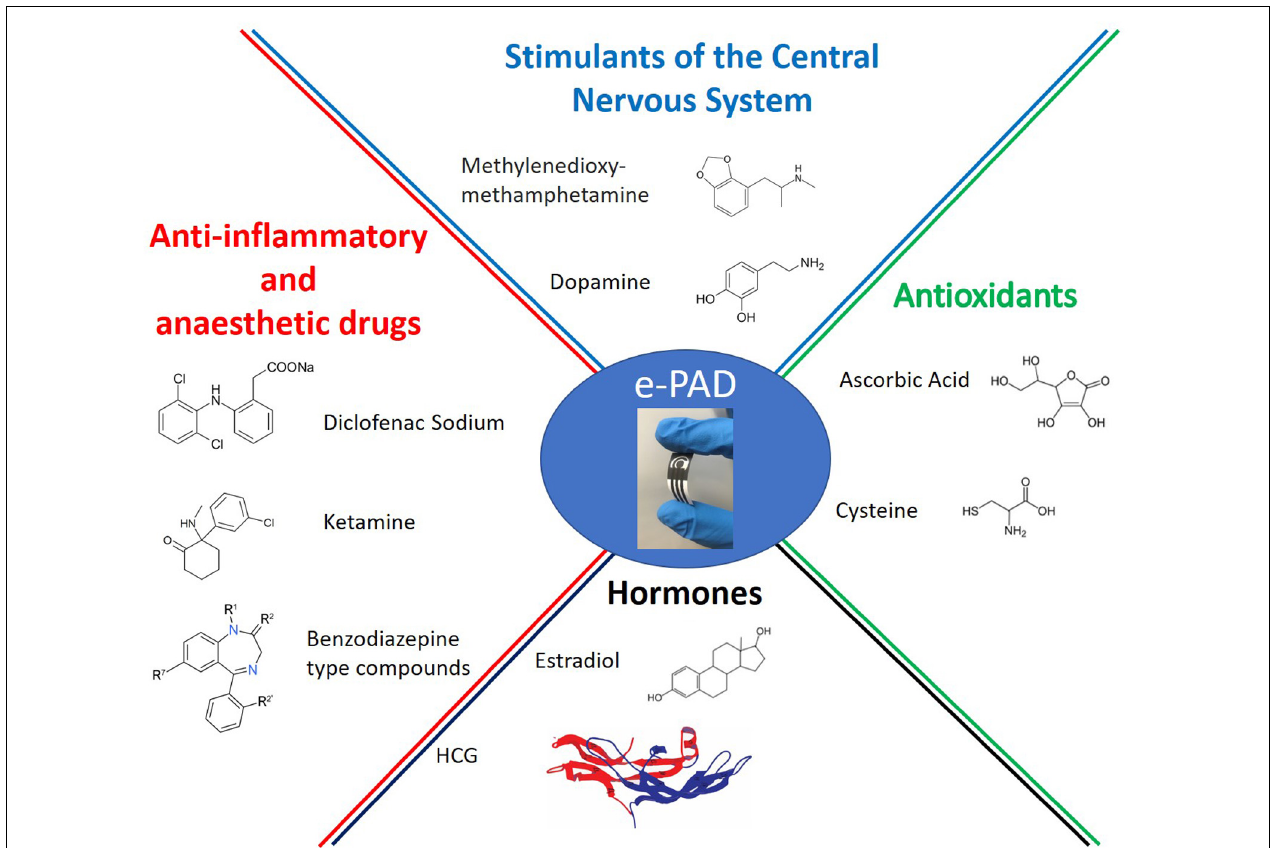
FIGURE 1 | Active pharmaceutical ingredients detected by e-PAD